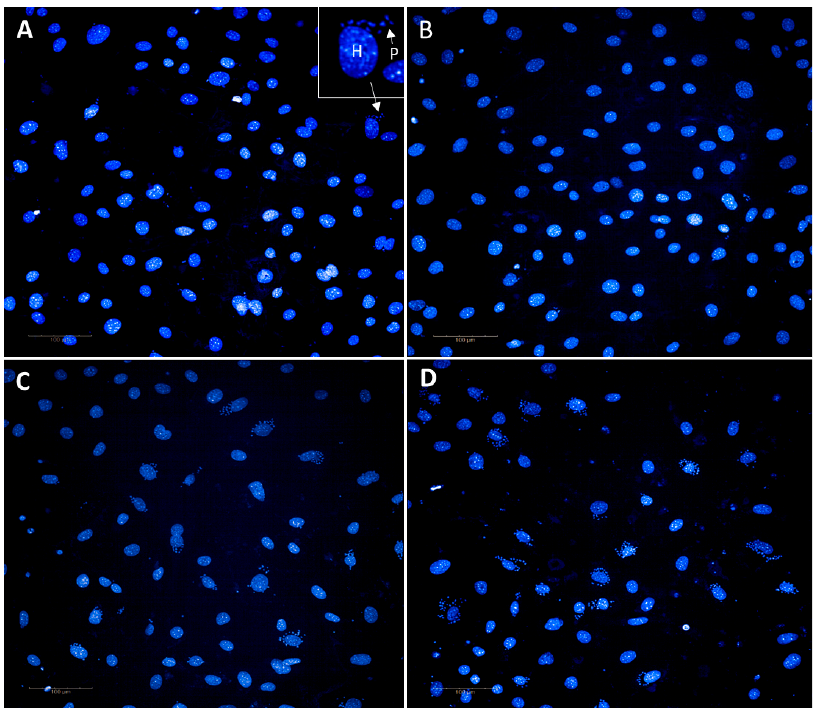
Figure 3. Images of 3T3 infected cells stained with the nuclear dye Hoechst, following treatment with 3.7 µ M of the eukaryotic cell cycle inhibitor, camptothecin. Cells infected with: ( A ) Tulahuen strain ( B ) CL strain ( C ) G strain and ( D ) Y strain. The nucleus of parasites and host cells stained with Hoechst are shown in blue, demonstrated in ( A ), inset, where P = parasite nuclei, H = host cell nu- cleus. A mean of 19.4 ± 2.3% more infected cells was observed for the G and Y strains, in comparison to Tulahuen and CL strains, following treatment. Images taken at 20× magnification using a Phenix (PerkinElmer) imaging system.